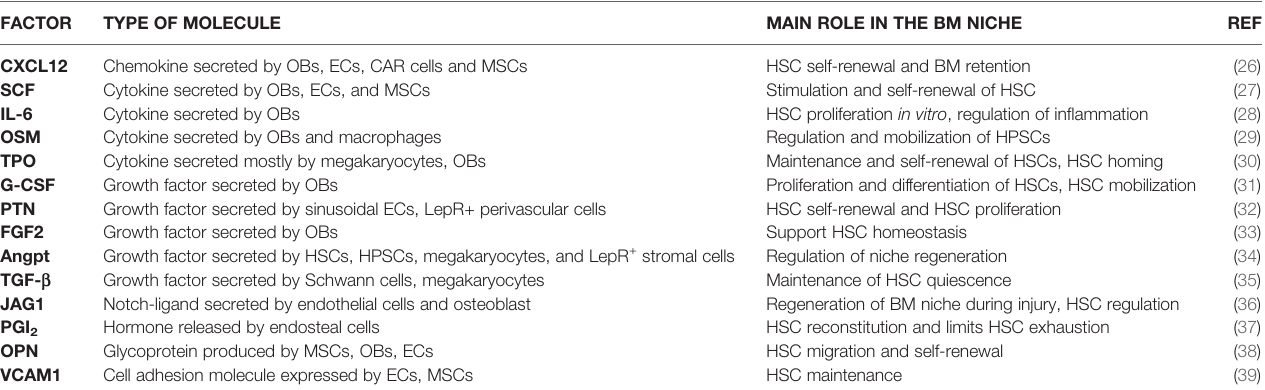
TABLE 1 | Soluble factors in BM